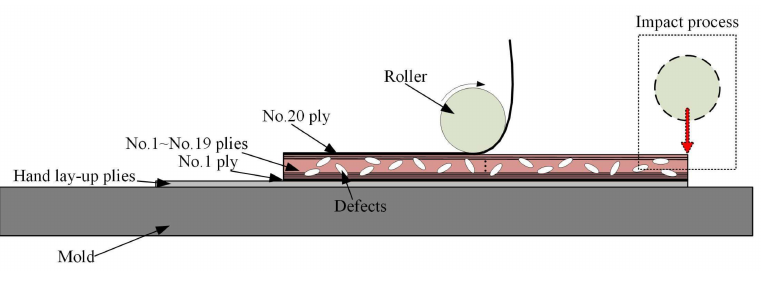
Figure 3. The experimental scheme.